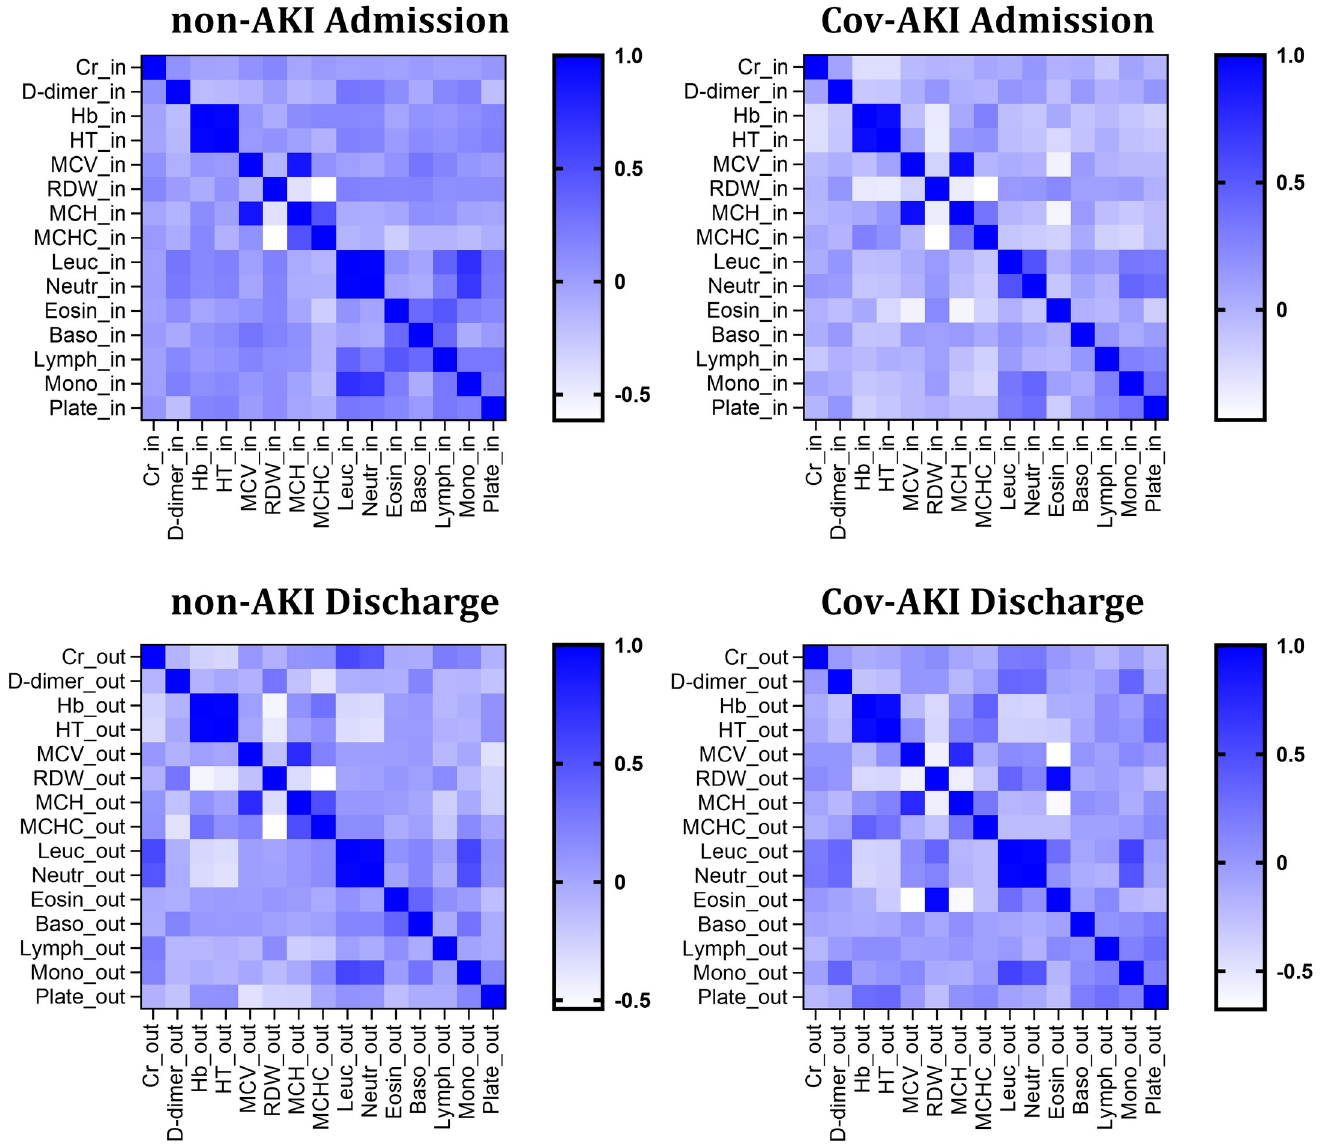
Fig 3. Correlation matrix among clinical variables at hospital admission and discharge. COVID-19 patients with AKI (Cov-AKI) and without AKI (non-AKI) were analyzed by Euclidean Distance Matrix according to relevant serological and blood markers between the admission and discharge periods of hospitalization. 2-tailed Pearson Correlation was ranged from 1 (blue color) to -1 (white color); (data with p < 0.05).